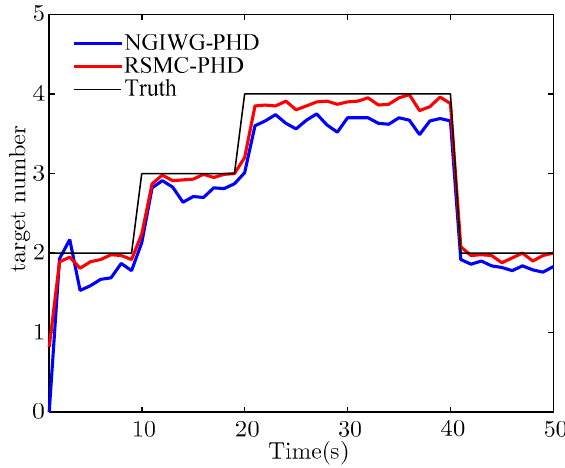
Figure 10. The estimate of target number.